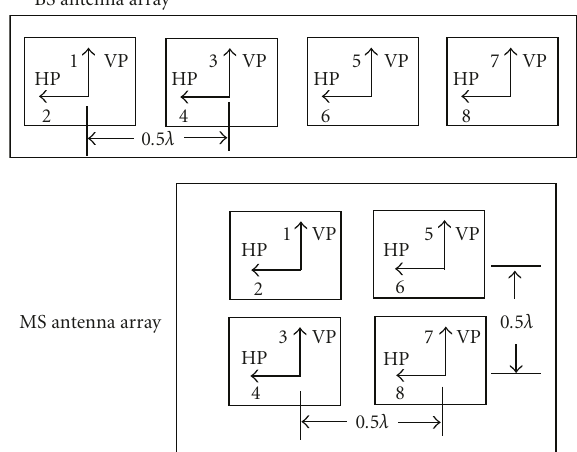
Figure 4: Selected BS and MS antenna